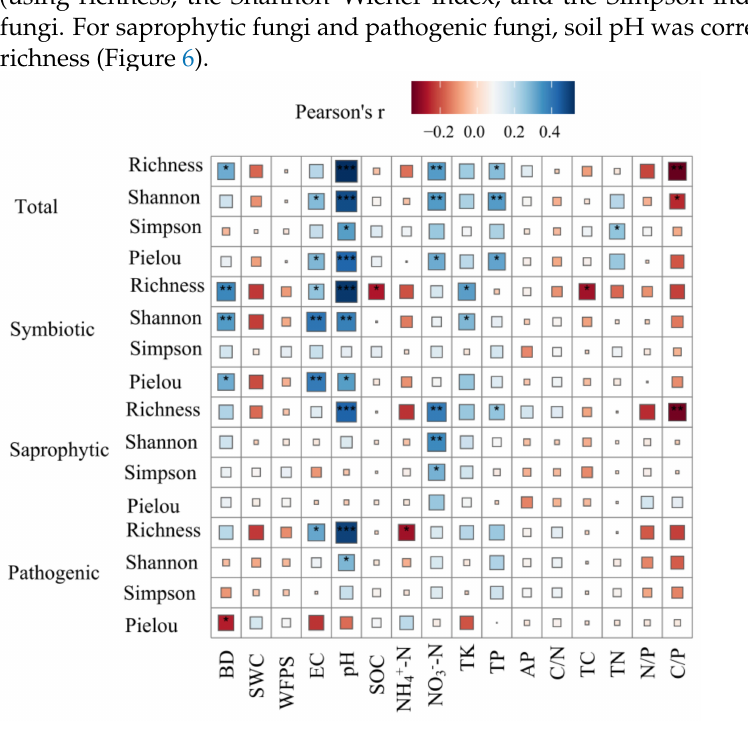
Figure 6. Pearson correlation analysis results of α -diversity of soil fungi and soil properties. Asterisks indicate significance level. *, p < 0.05; **, p < 0.01; ***, p <